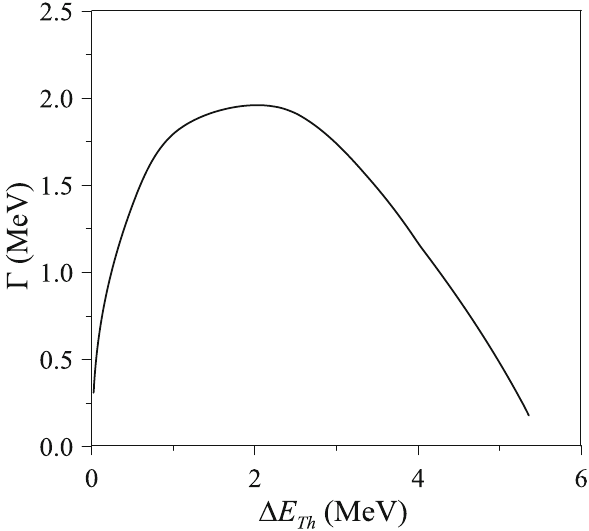
Fig. 2 Widthoftheresonance, (cid:3) ,asafunctionoftheenergydifference between its mass and the mass of the lower threshold generating the state, (cid:4) E Th = W R − m 1 − m 2 . In this case the upper channel is 5.6 MeV above the lower